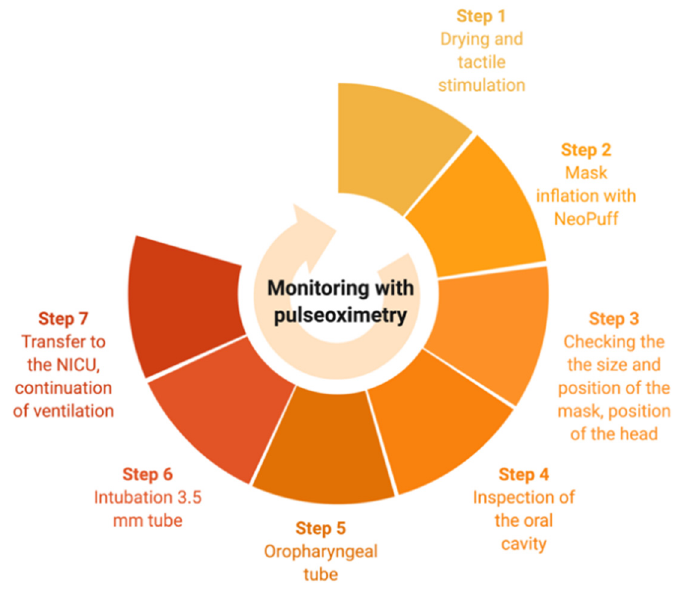
Figure 1. A timeline of actions performed to achieve airway control in the delivery